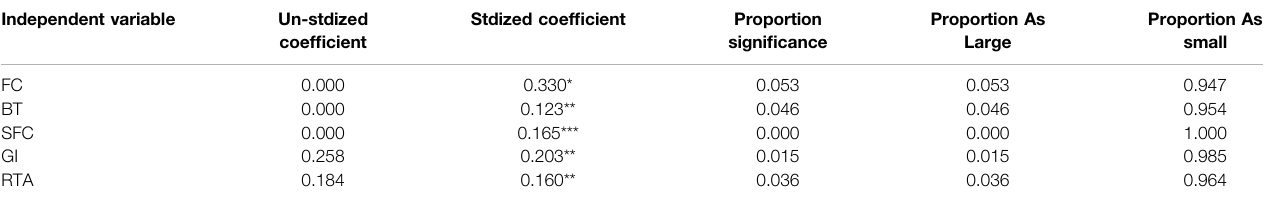
TABLE 8 | Results of QAP regression analysis in 2014. Independent